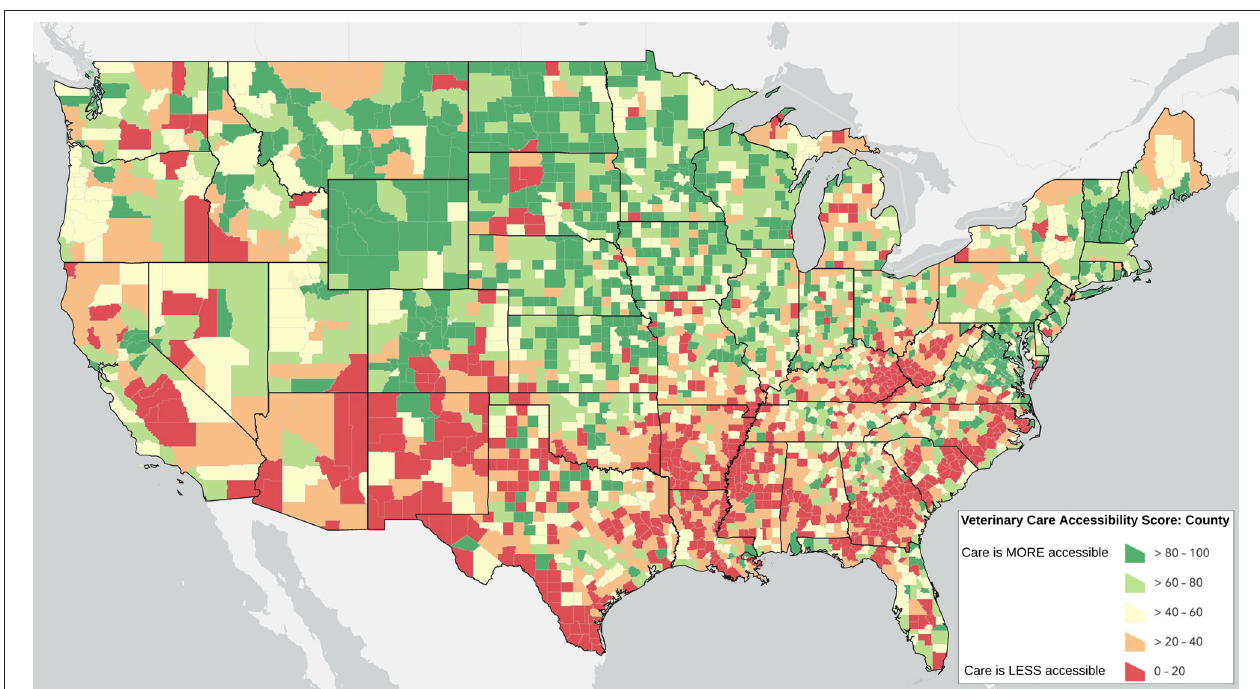
FIGURE 1 | The Veterinary Care Accessibility Score: a relative measure of accessibility to veterinary care across the contiguous US. An online interactive and routinely updated map is available at: